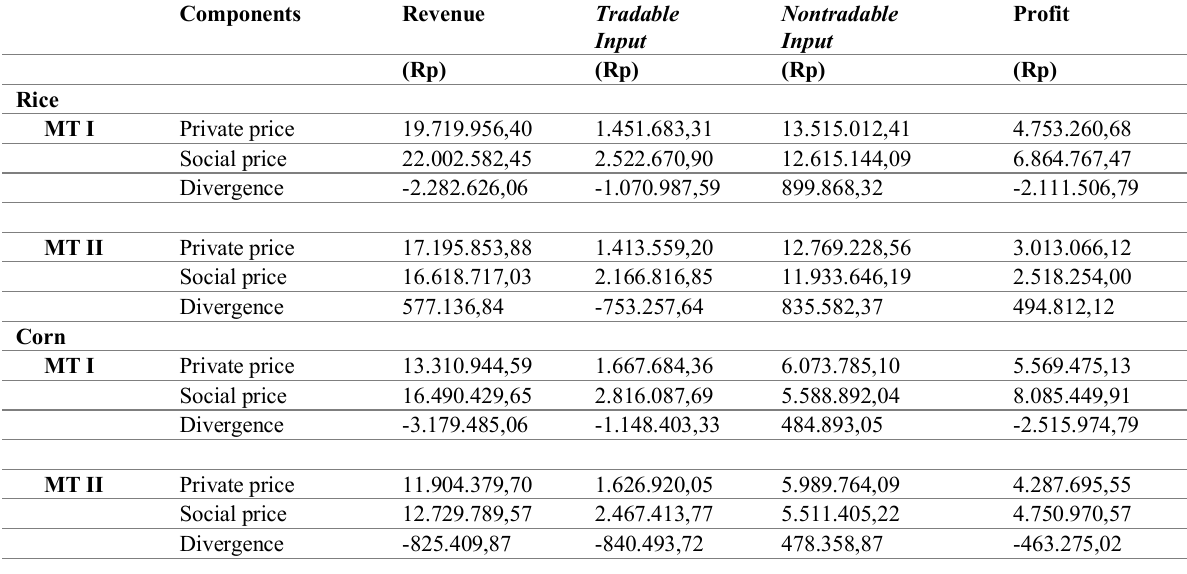
Table 4: Policy Analysis Matrix of strategic food commodities farming (per hectare) in Lampung Province,